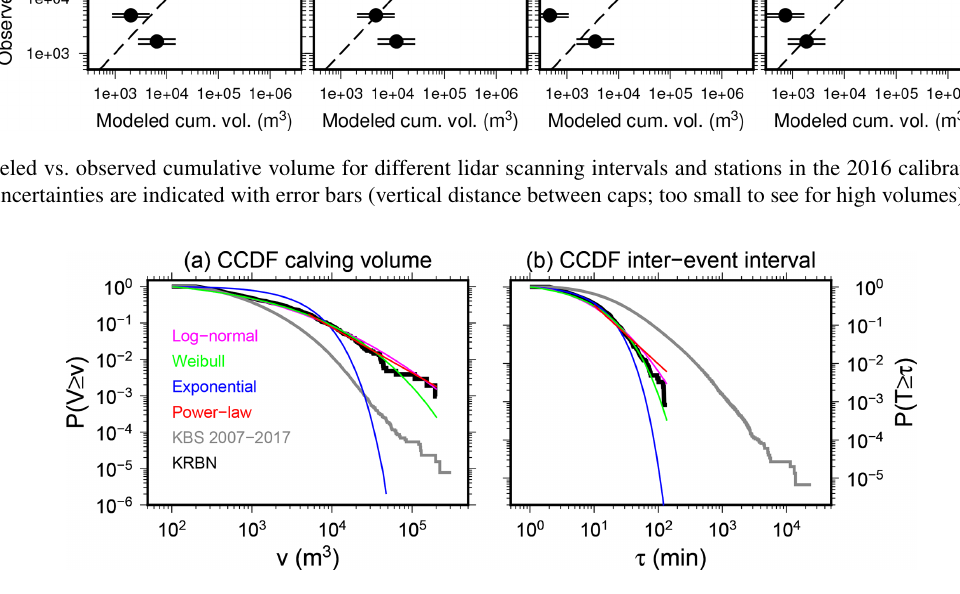
Figure 6. Complementary cumulative distribution functions (CCDFs) for calving event volume ( v ) estimated with our model from seismic signals and observed inter-event interval ( τ ). Different distribution models are fitted to the data (KRBN only). Log-likelihood ratio (positive value favors first model) and their significance for two candidate distributions (power-law, P ; exponential, E ; lognormal, L ; Weibull, W ): (a) P/E : 41.8, 0.017; P/L : − 1 . 4, 0.35; P/W : − 1 . 4, 0.34; L/E : 43.2, 0.008; L/W : − 0 . 0017, 0.98; E/W : − 43 . 2, 0.00; (b) P/E : − 2 . 0, 0.85; P/L : − 15 . 8, 0.001; P/W : − 15 . 0, 0.0007; L/E : 13.8, 0.02; L/W : 0.8, 0.3; E/W : − 13 . 0,